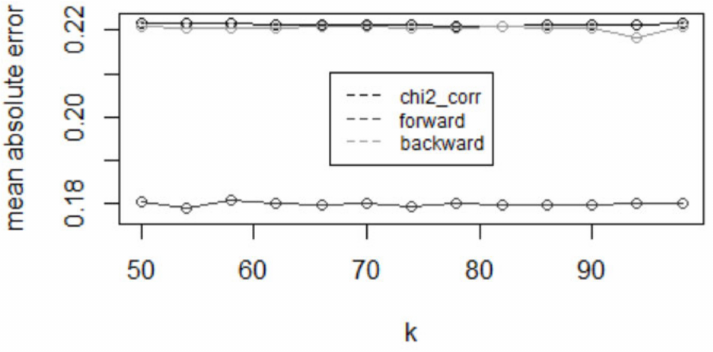
Figure 3. The selection of parameter K for the KNN classifier.